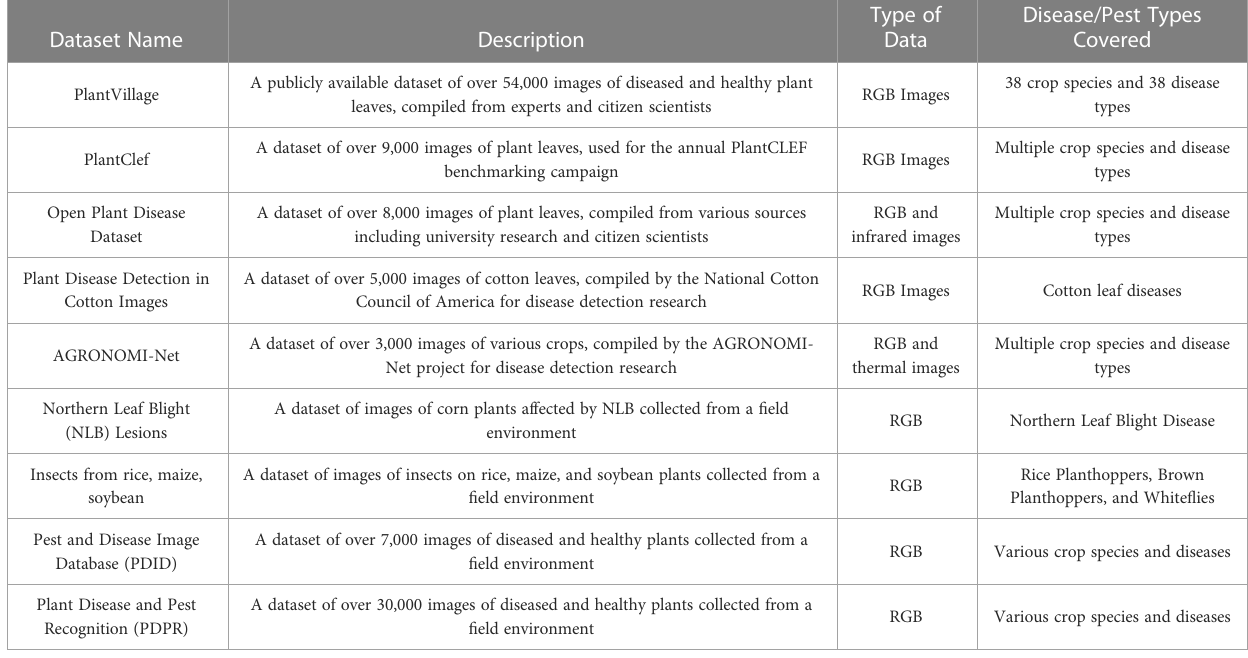
TABLE 4 Plant disease and pest detection from benchmark